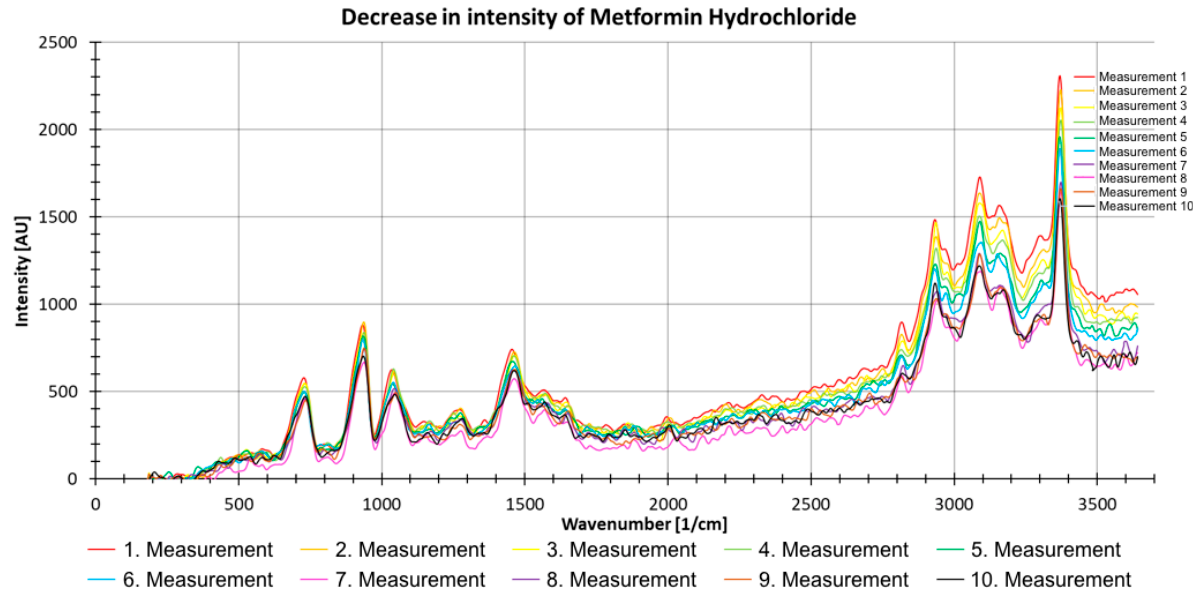
Figure 11. Decrease in intensity of 10 consecutive Raman measurements (with 500 pulses) of metformin hydrochloride as a powder.